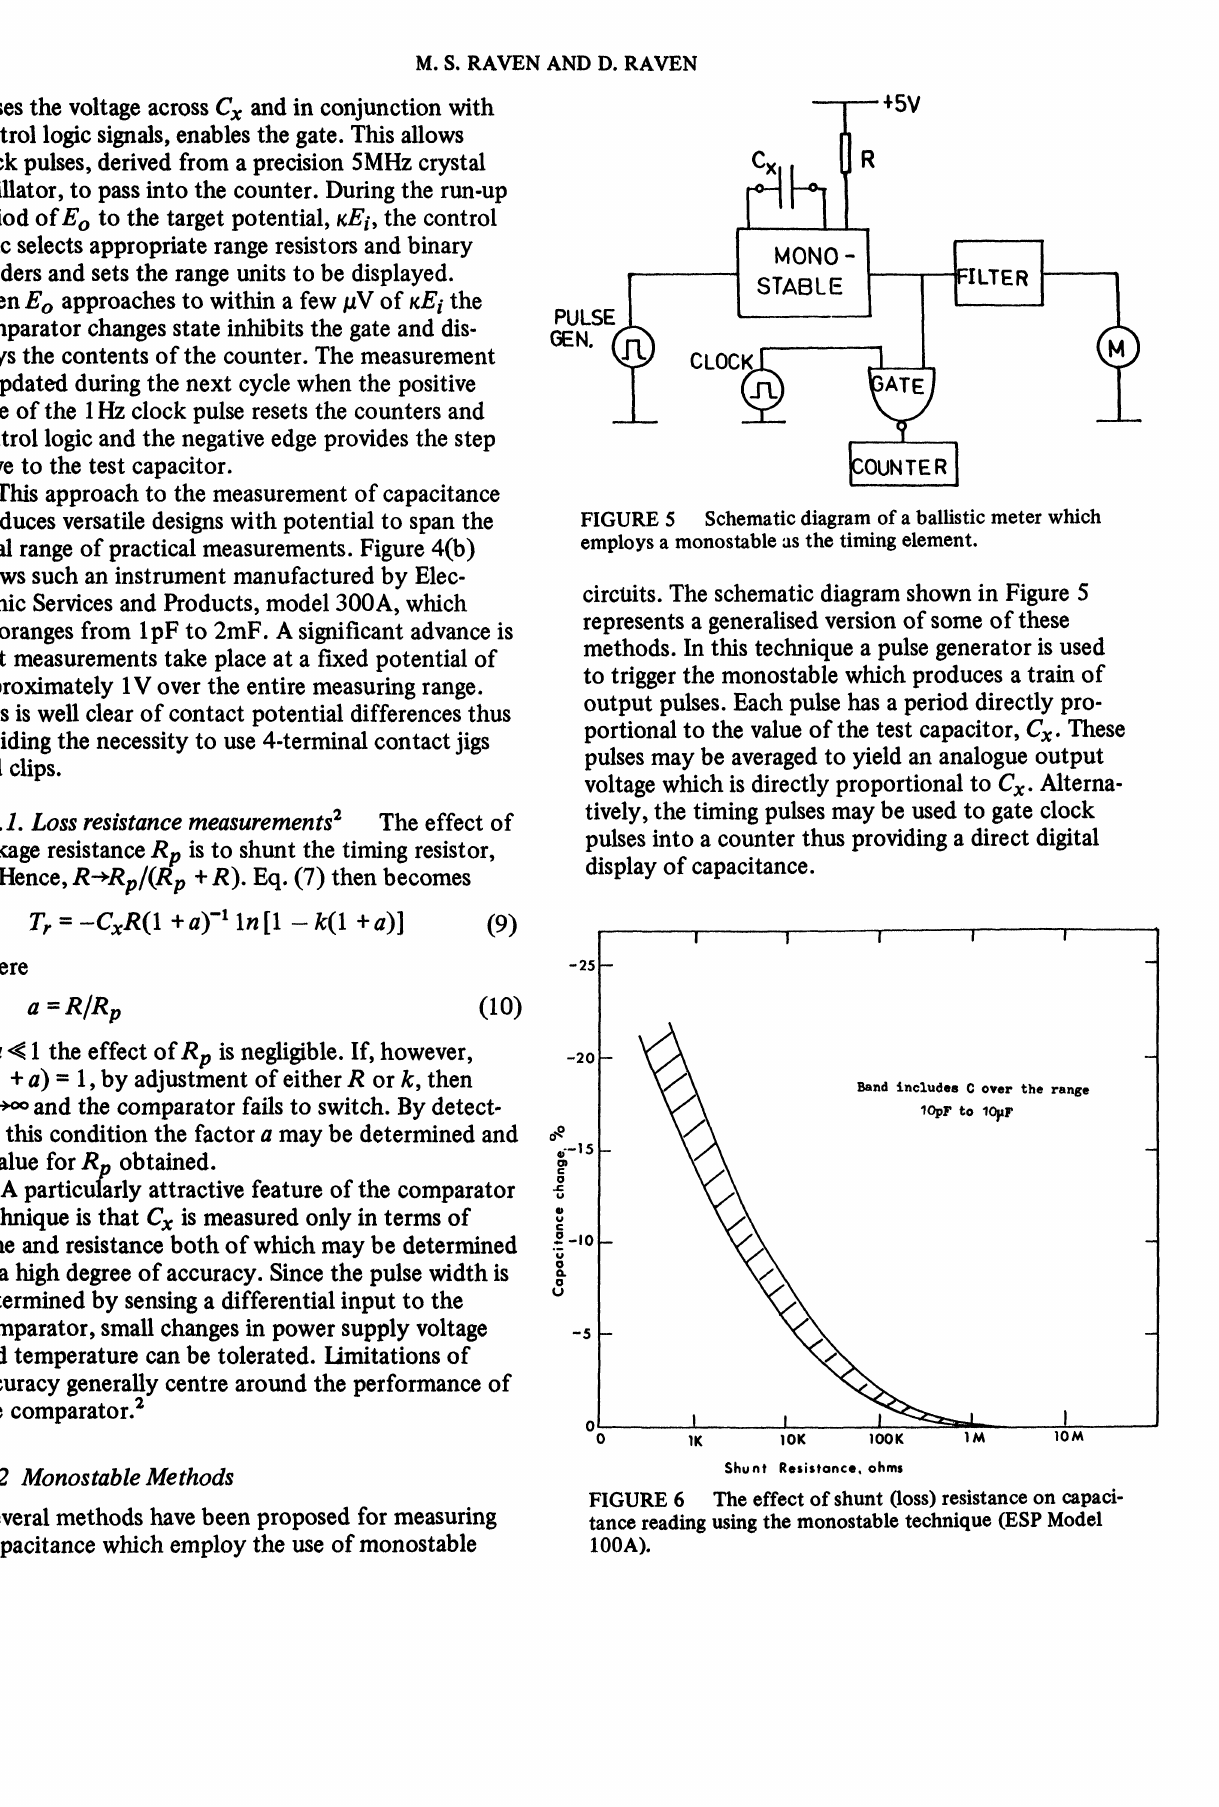
The effect of shunt (loss) resistance on capaci- tance reading using the monostable technique (ESP Model